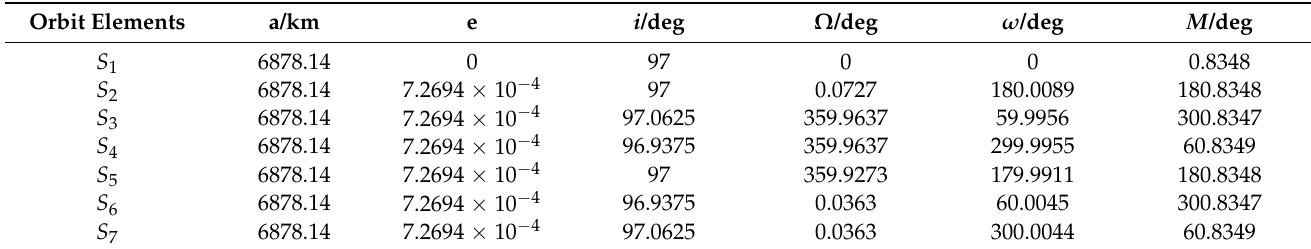
Table 3. Orbit elements of the seven- satellite space-circle formation (space-circle radius of 10 km).